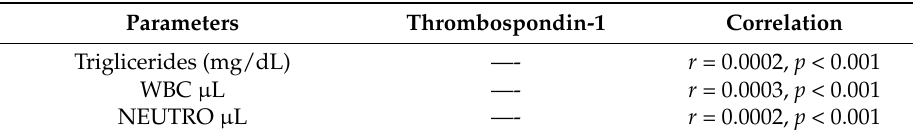
Table 7. Correlation of TSP-1 plasma levels with all data in Group